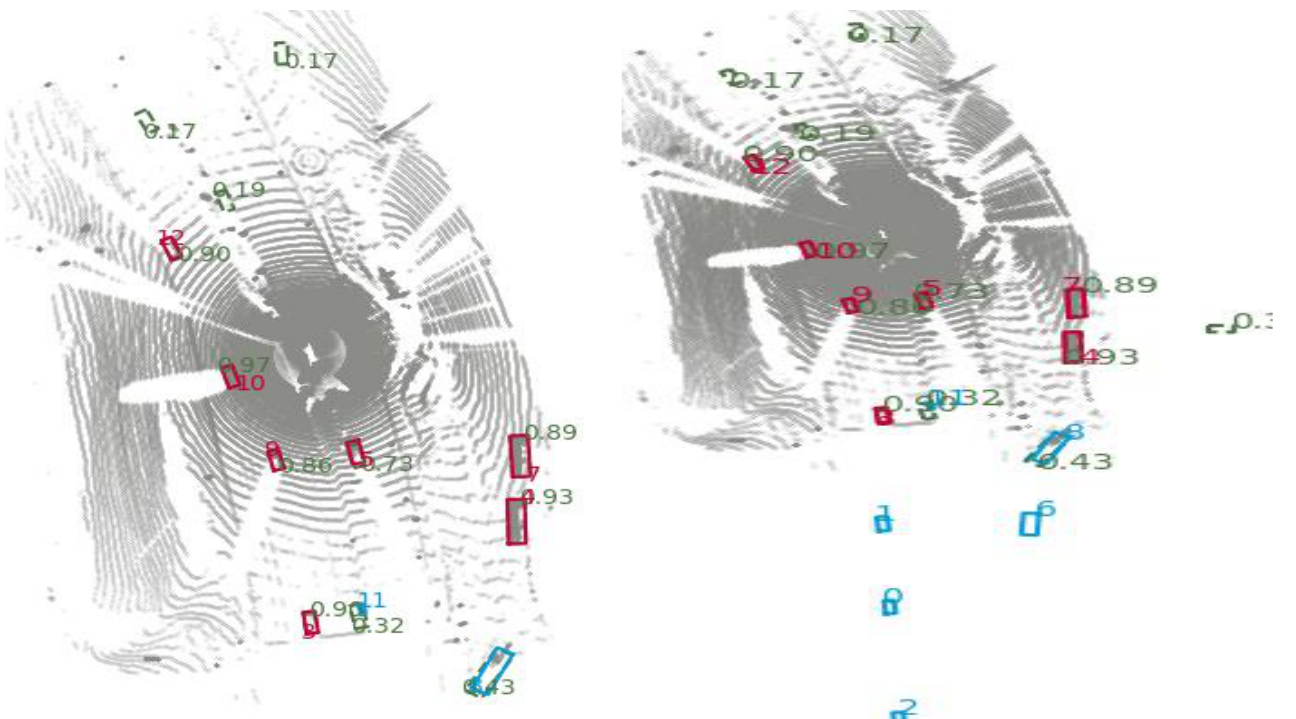
Frame 28, tracklet for vehicle 3 and 11 and predicted position for vehicle 0, 1, 2, 6. Figure 6. Comparison between GIoU and DIoU for Association process. Figure 6. Comparison between GIoU and DIoU for Association